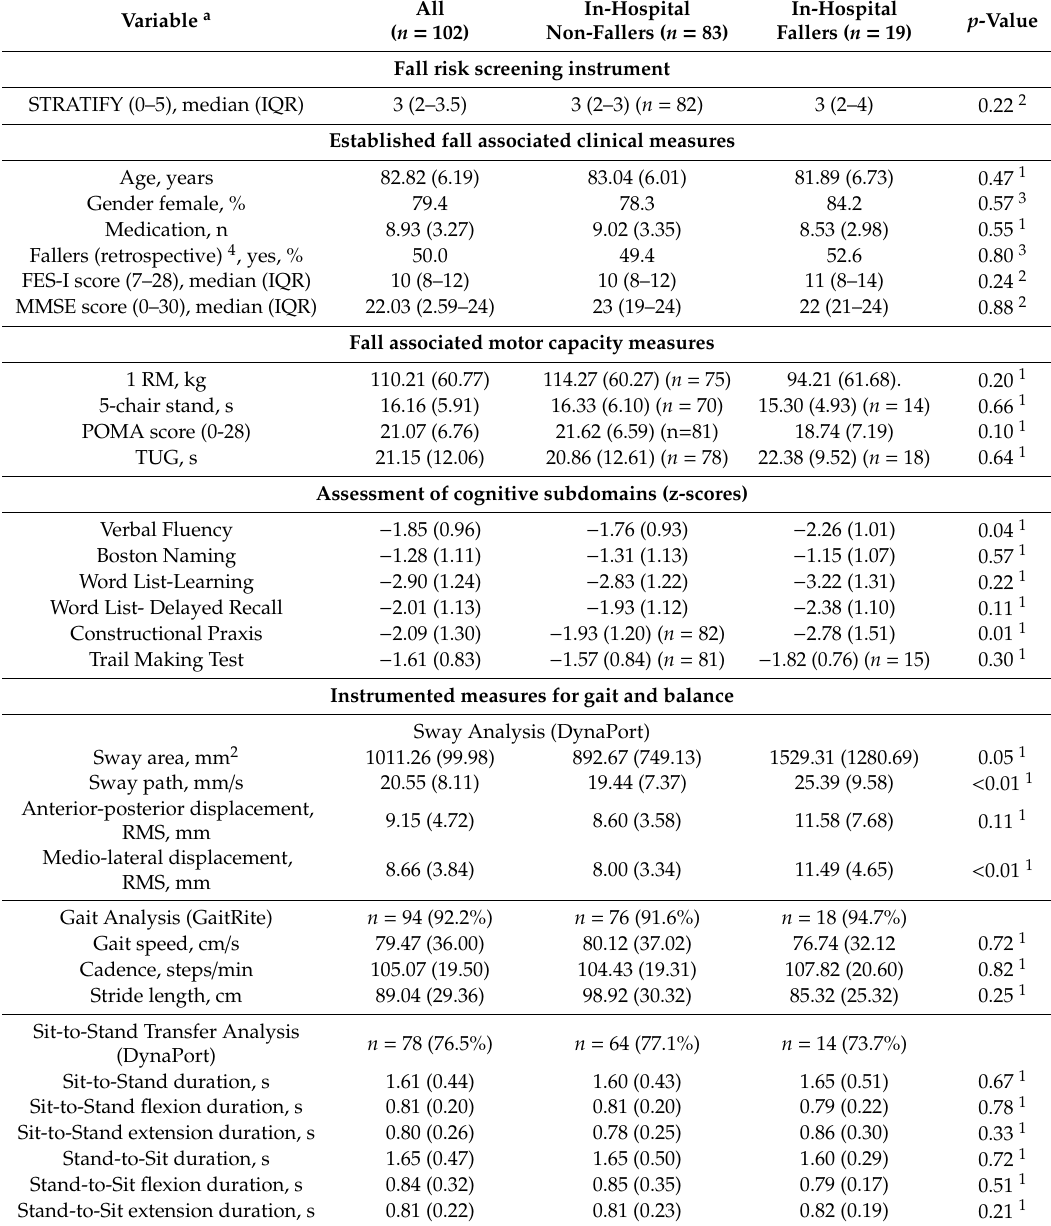
Table 2. Characteristics and di ff erences between in-hospital fallers and non-fallers. Variable a